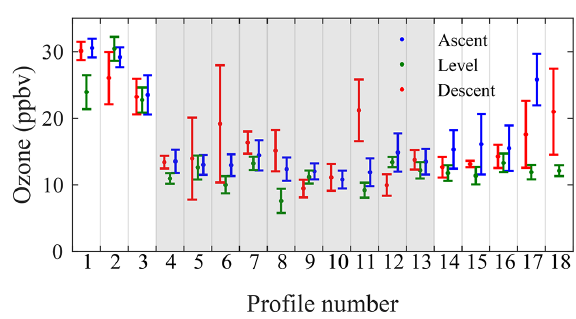
Figure 9. Synoptic chart from ECMWF ERA-Interim data from 10 March at 00:00UTC. The three tropical cyclones are labelled, along with their central minimum pressure.